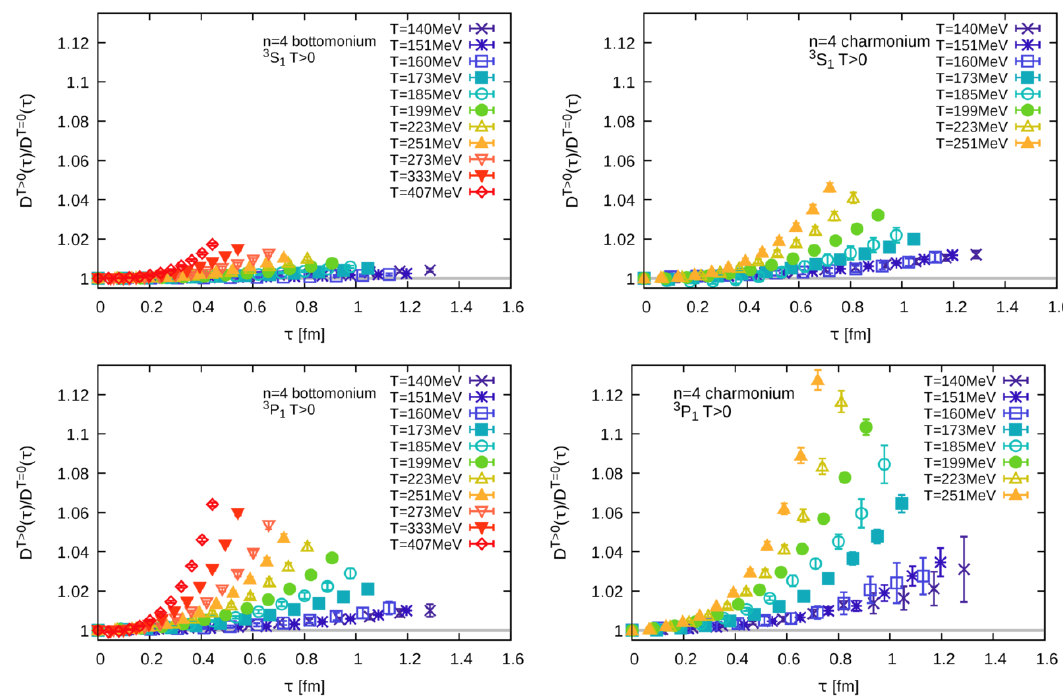
Figure 16 . Ratio of the raw NRQCD correlators at (cid:12)nite temperature with their corresponding T = 0 counterparts. We show bottomonium results on the right and charmonium on the left. The top row features the ratios for the 3 S 1 channel while in the bottom row the 3 P 1 results can be found. Note that the strength of the upward bend, when compared at the same temperature shows a clear ordering according to the vacuum binding energy of the ground state in that channel E (cid:7)(1S)